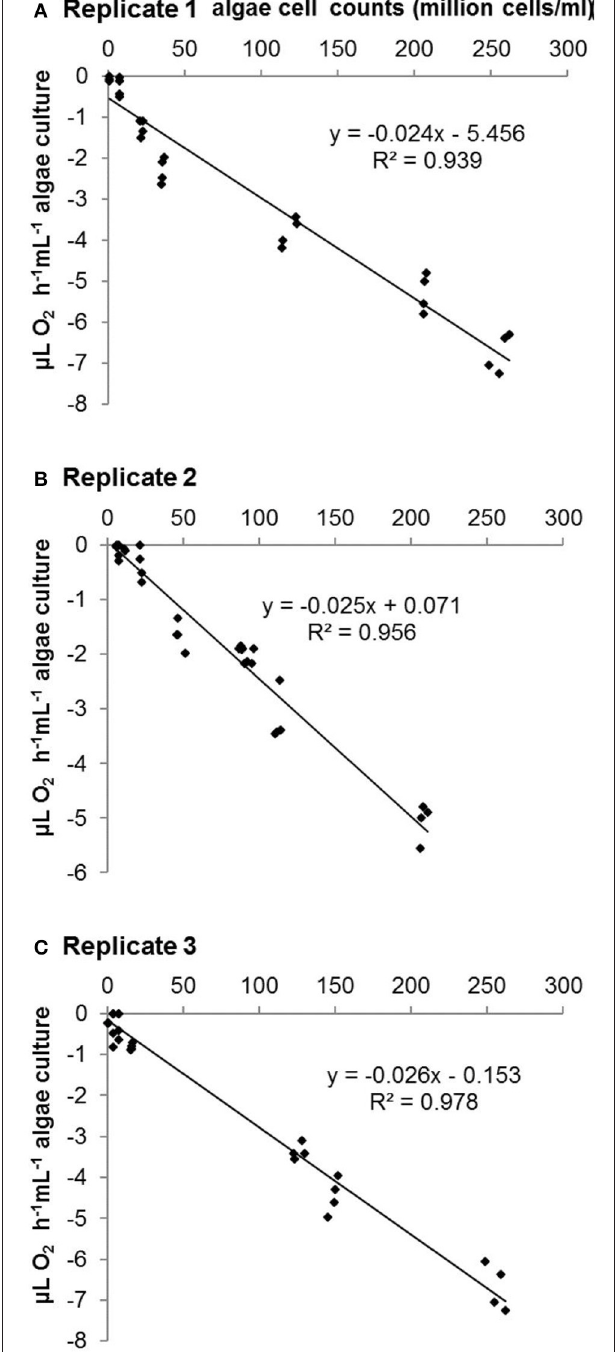
FIGURE 3 | Relationship between O 2 assimilation rate and C. vulgaris cell number estimated by CASY ® cell counter with 10mL test samples in three repeats. (A-C) Replicate 1-3.